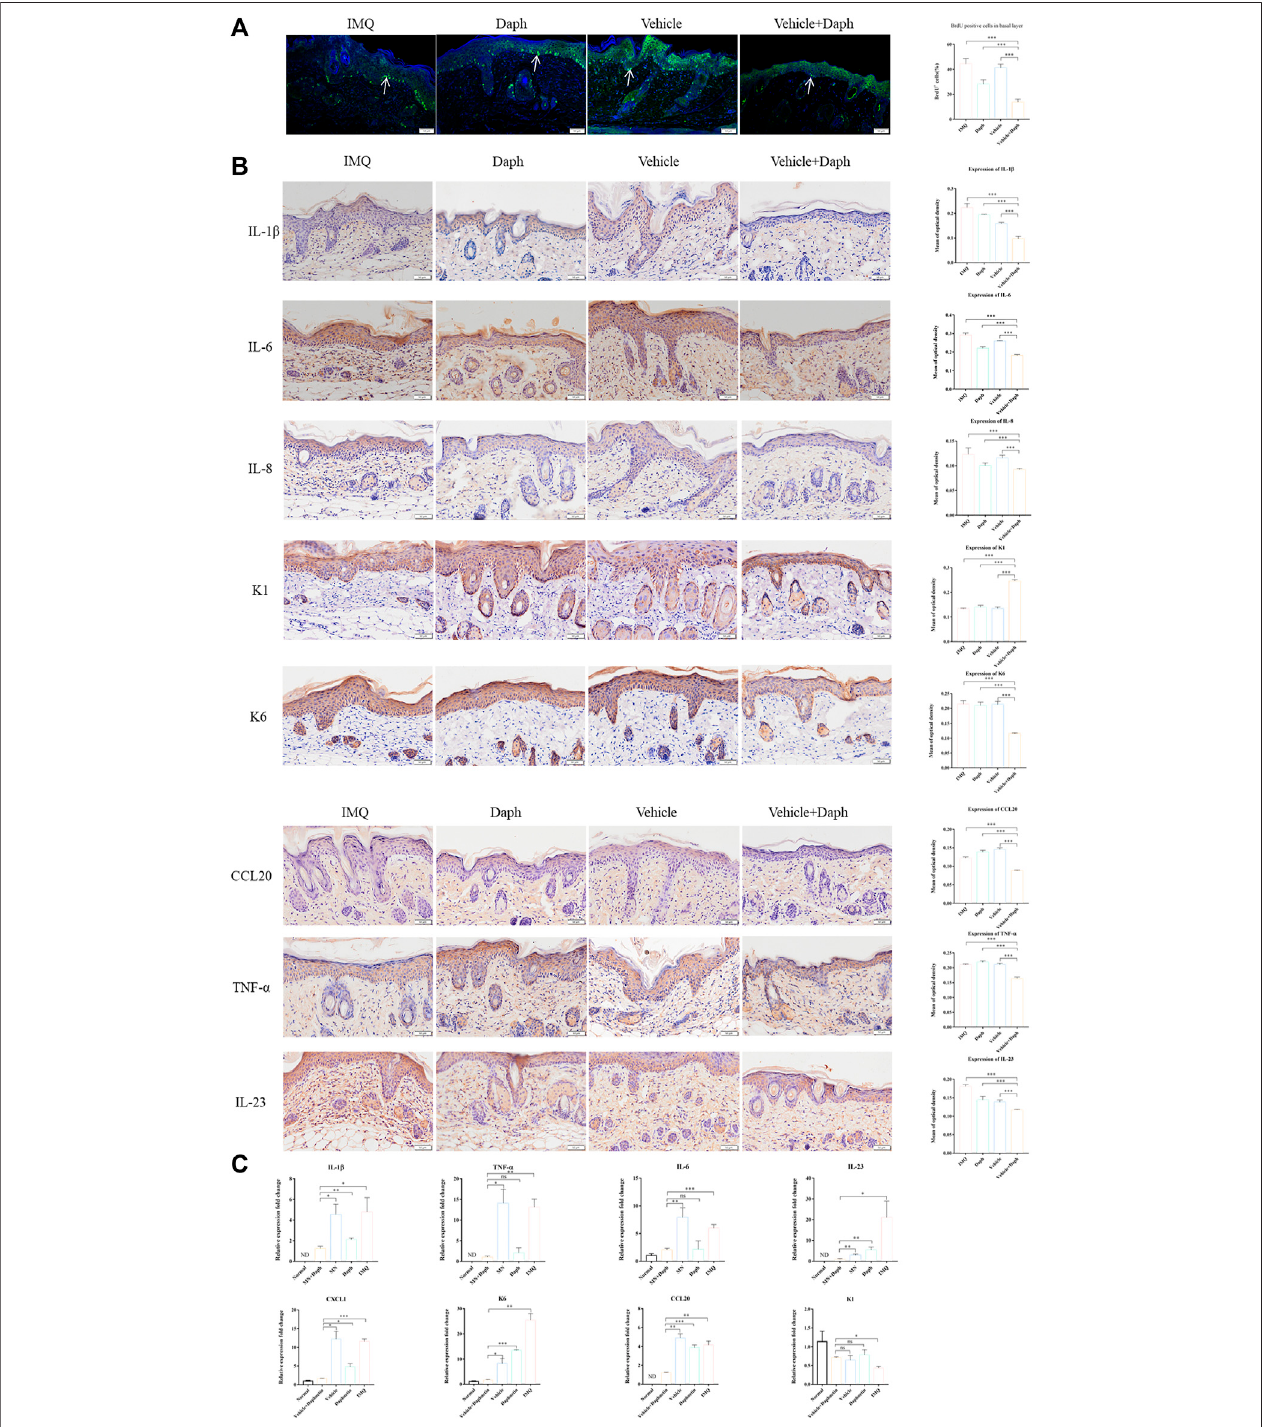
FIGURE5| Proliferationratioofkeratinocytesandthesecretionofin fl ammatoryfactorsinpsoriaticmiceweredetected. (A) Proportionofkeratinocytesinpsoriasis modeling sites in each group; DAPI was labeled with blue fl uorescence and BrdU was labeled with green fl uorescence. (B) Immunohistochemical staining of major in fl ammatory factors (IL-1 β , IL-23, TNF- α , IL-6, IL-8, and CCL20) secreted by keratinocytes and the expression of in fl ammatory factors were counted by the mean optical density. (C) qPCR detection results of skin-related in fl ammatory factors (IL-1 β , IL-23, TNF- α , IL-6, CXCL1, and CCL20) at the mouse modeling site. Data are shown as mean ± SE (* p < 0.05; ** p < 0.01).